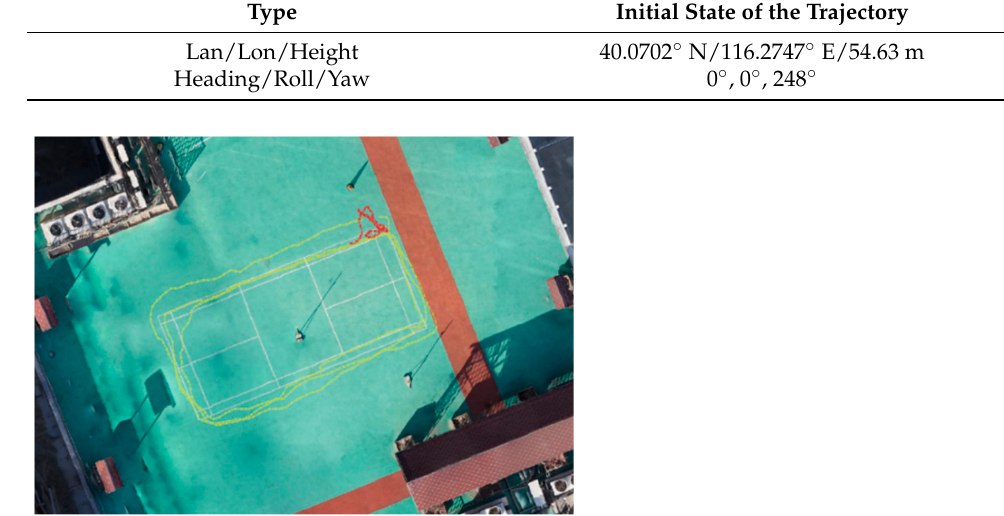
Figure 7. Trajectories of data set 1 (red line) and data set 2 (yellow line) exported by the RTK receiver.